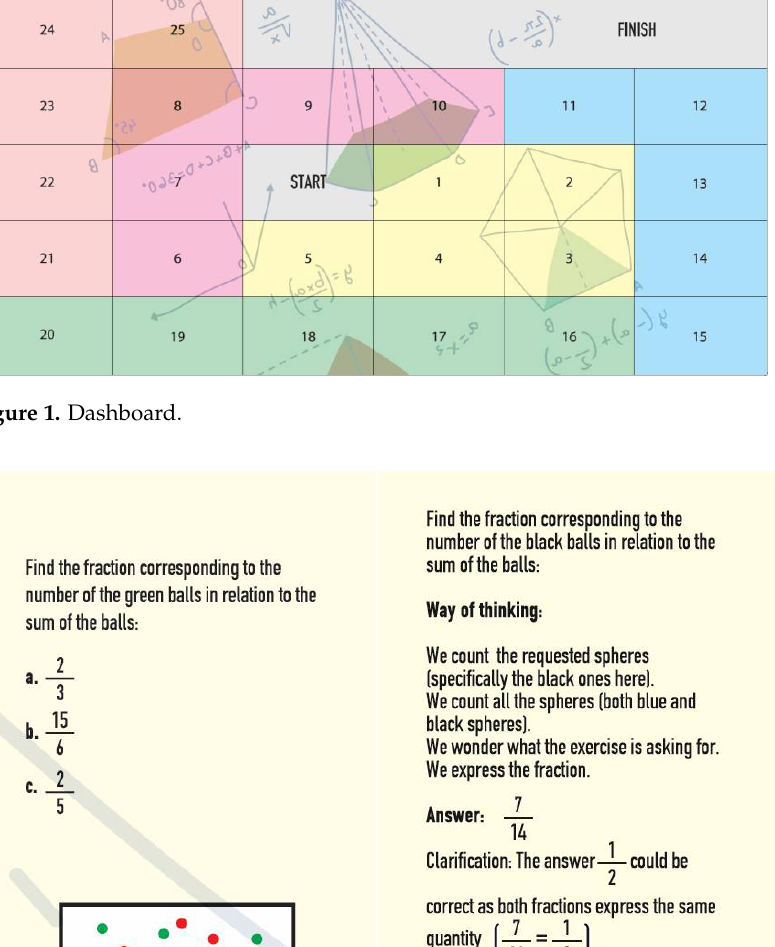
Table 4. Reliability Statistics.